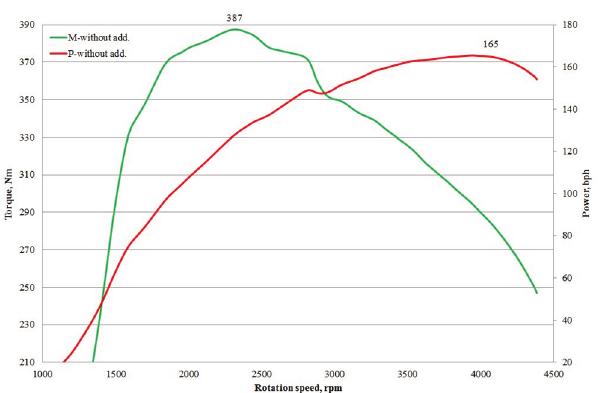
Fig. 1. Full load characteristic of tested engine supplied by diesel fuel without additives